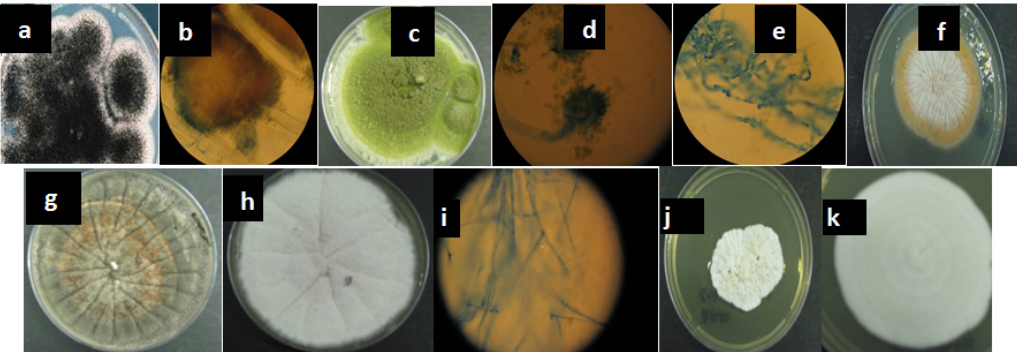
Fig. 1. Cultured fungal species from various processed food. The identity of the fungil are represented by letters a to k: a= Aspergillus niger on SDA media; b= Aspergillus niger conidia; c= pure culture of Aspergillus flavus; d= Conidia of Aspergillus parasiticus; e= pure culture of Fusarium biseptatum on SDA media, f= A-pure culture of F biseptatum on SDA media, g= pure cultures of Fusarium oxysporum on SDA media; h= pure cultures of Fusarium oxysporum ; i= pure culture of Penicillium corylophilum on SDA media; j= Trichosporon. insectorum , k= Trichosporon asahii